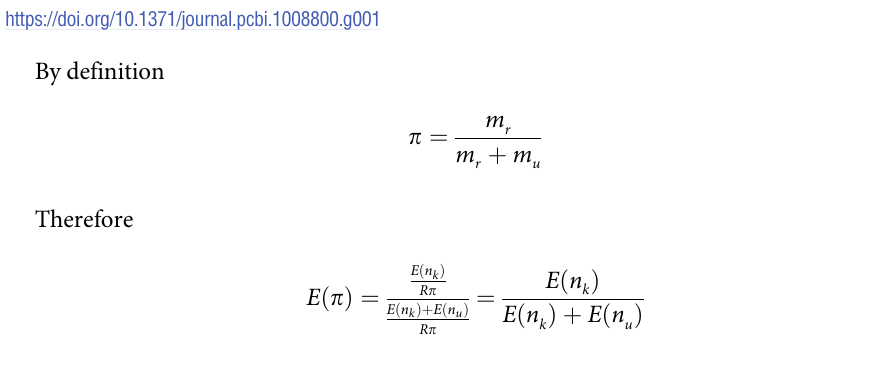
Fig 1. Rationale of the method for estimating reporting. This diagram illustrates transmission events inferred by case investigation of reported secondary cases, with arrows pointing from infectors to infectees. Darker shades are used to indicate documented transmission events, while lighter shades show unknown infectors. Numbers of secondary cases with (blue) or without (orange) known infectors are used to estimate the reporting probability. This example uses an approximate reporting of